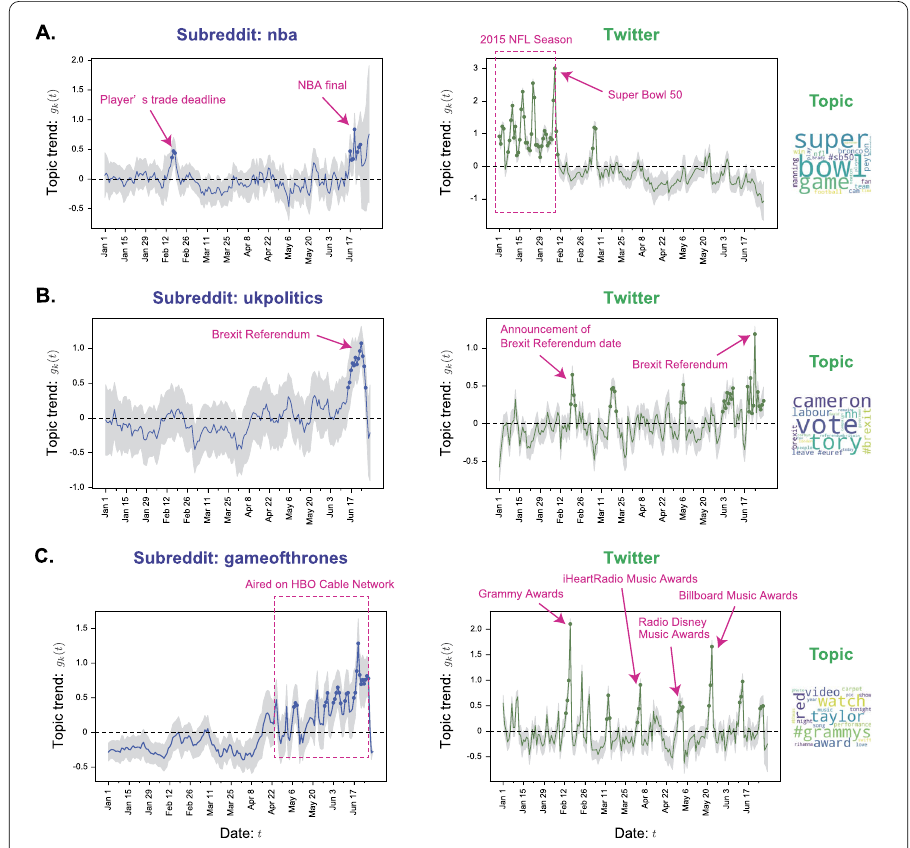
Figure 3 Our predictive model can extract the topic trends which are related to news and social events. Topic trend extracted from three topic categories (( A ) Sports, ( B ) Politics, and ( C ) Entertainment) are shown. The blue and green lines represent the mean topic trend of Reddit and Twitter, respectively, and the gray area represents the 95% confidence interval. Filled circles mark the days when the topic trend estimate is significantly higher than zero for at least three consecutive days. Social events manually identified from Wikipedia are written in